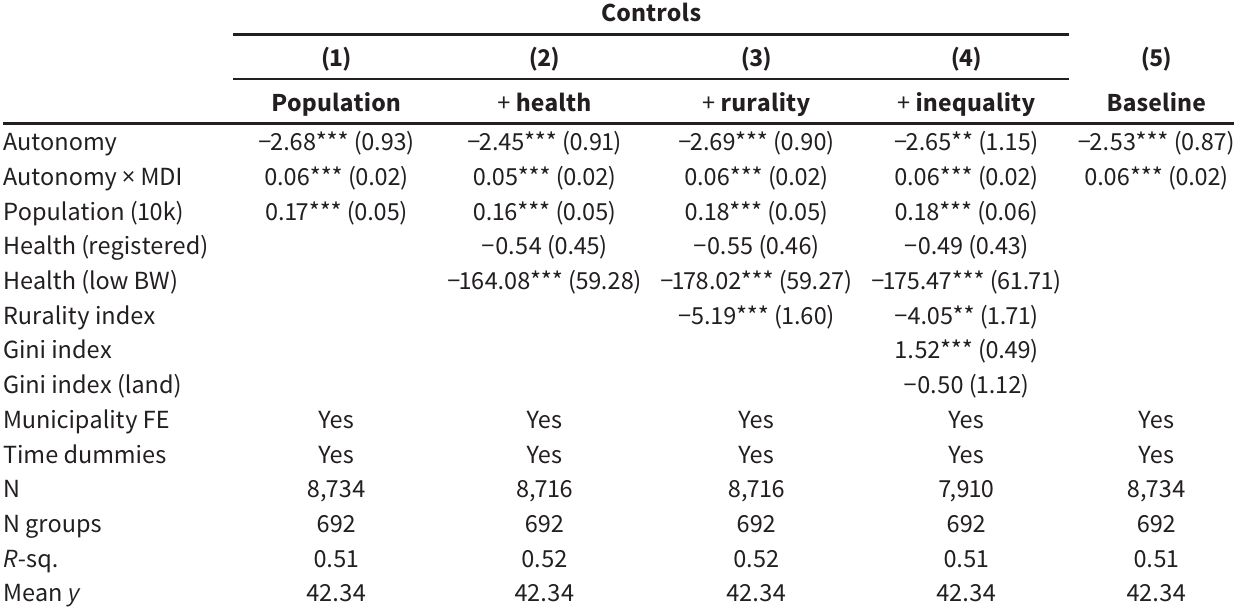
The effect of municipal autonomy on test scores - with controls